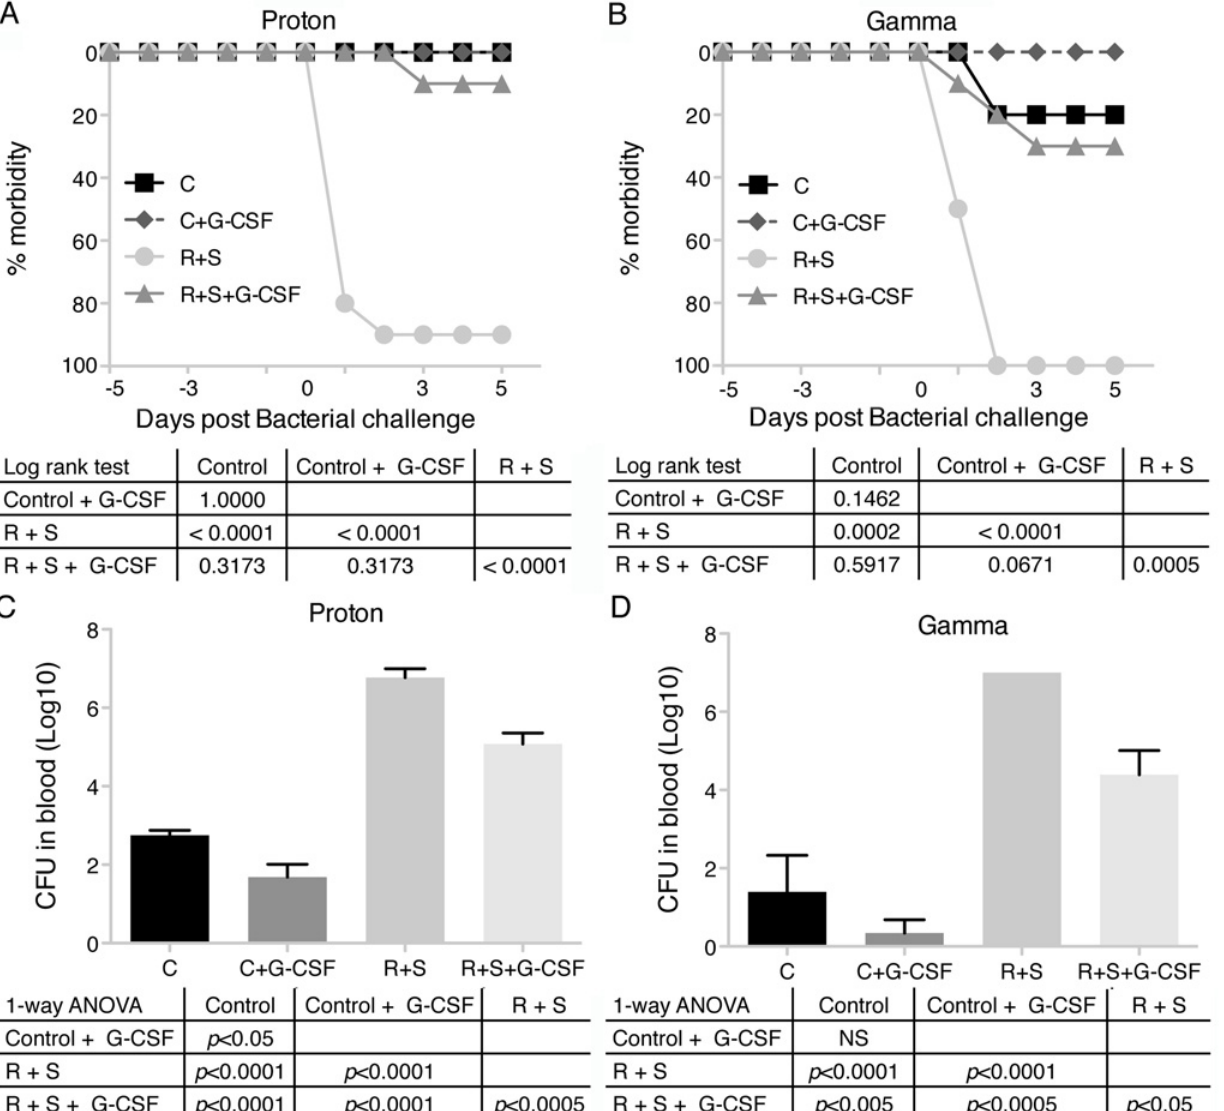
Fig 4. Treatment with G-CSF reduces morbidity and increases bacterial clearance of irradiated and hindlimb suspension mice systemically challenged with Pseudomonas aeruginosa . Sets of 10 mice per treatment group were irradiated with 2 Gy of protons or gamma rays and hindlimb suspended or not and injected with PBS or G-CSF (600 μ g/kg) by the subcutaneous route every 3 days until the end of the experiment. All groups were exposed to Pseudomonas aeruginosa by intraperitoneal injection 5 days after irradiation and followed. Morbidity scores (Table 1) were calculated (A — proton and B — gamma rays) daily and animals were considered morbid if their score increased by 3 points or remained 2 points elevated for 24 hrs. C = control, R + S = irradiated + hindlimb suspended. Bacteria in blood were quantitated 5 days after infection (C — proton and D — gamma rays). Values are means ± SEM of log 10 colony-forming units (CFUs). One-way ANOVA with Bonferroni ’ s correction for multiple comparisons was used to test the statistical significance of changes in CFUs. Kaplan-Meier curve statistical significance was measured by Mantel-Cox log rank